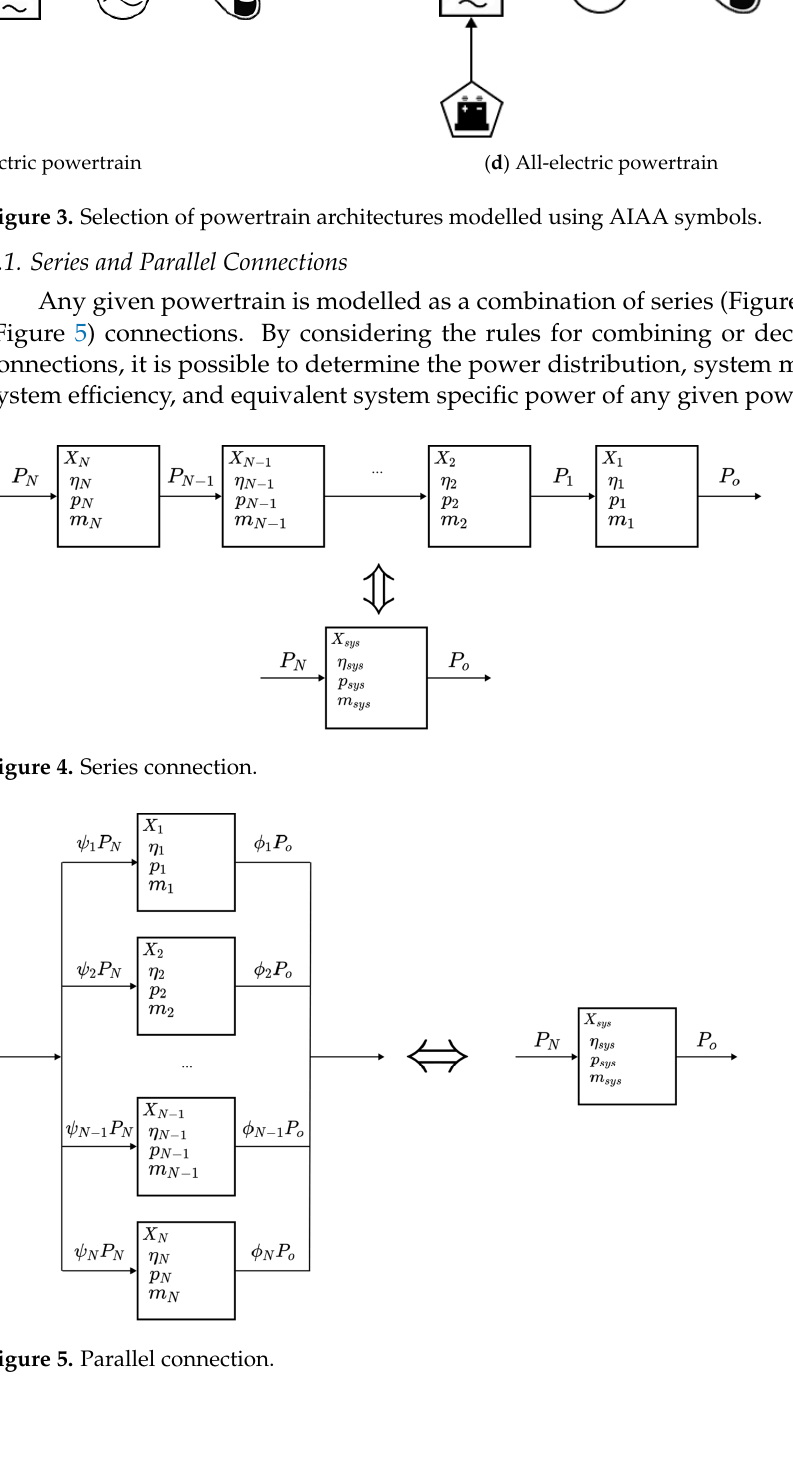
Figure 3. Selection of powertrain architectures modelled using AIAA symbols.